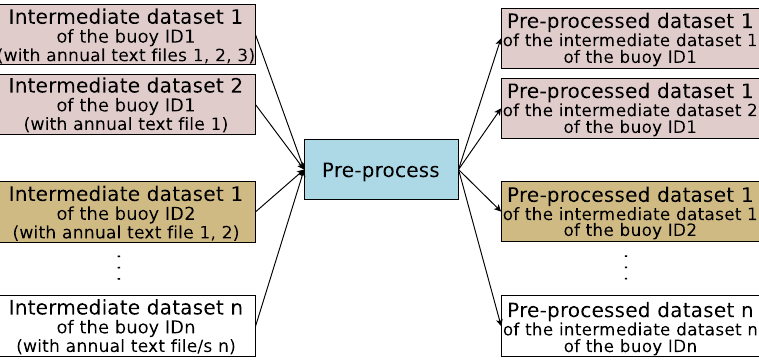
Figure 6. Example of the creation of pre-processed